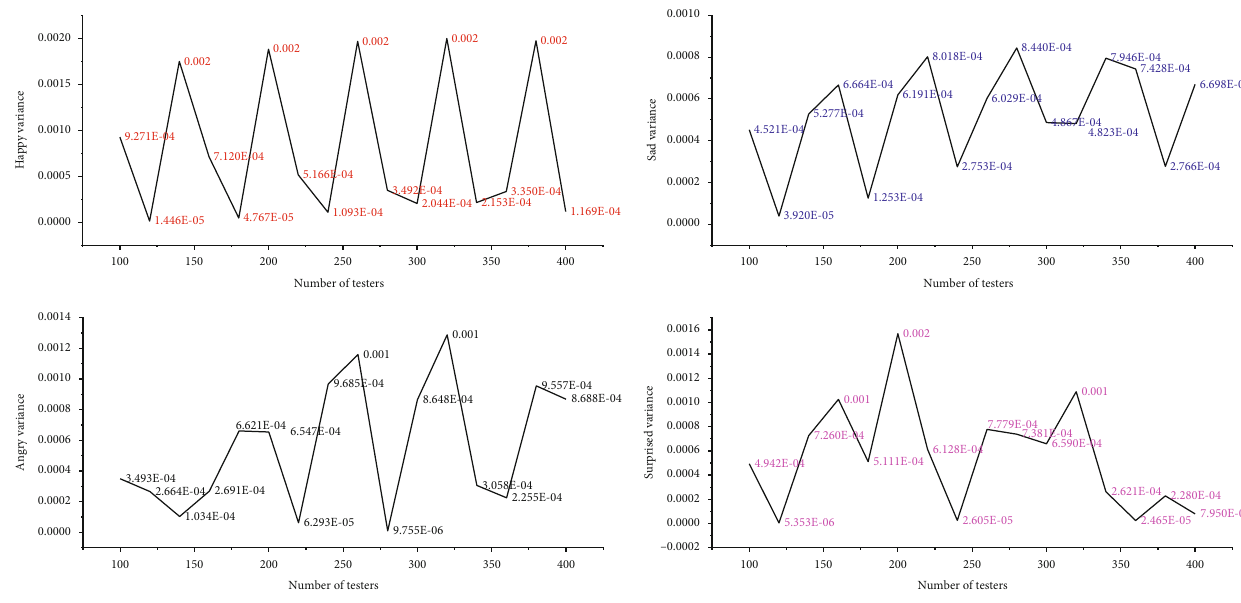
Figure 2: Emotional machine evaluation variance of di ff erent human evaluation levels. Table 1: Mean value of speech emotion evaluation